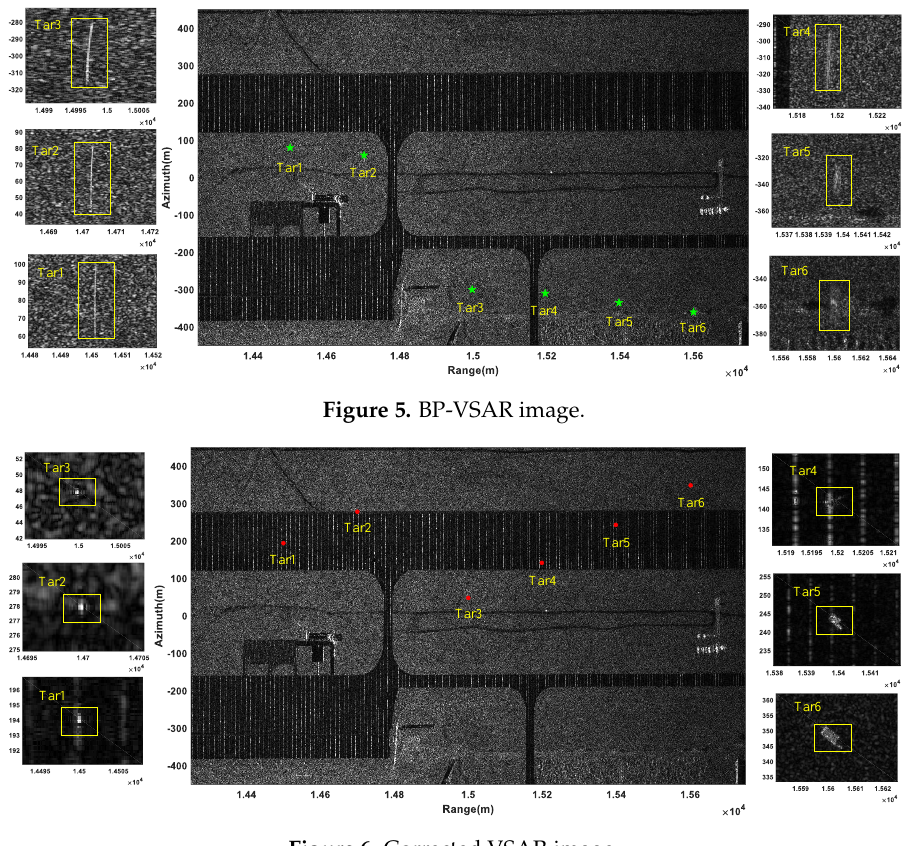
Figure 6. Corrected VSAR